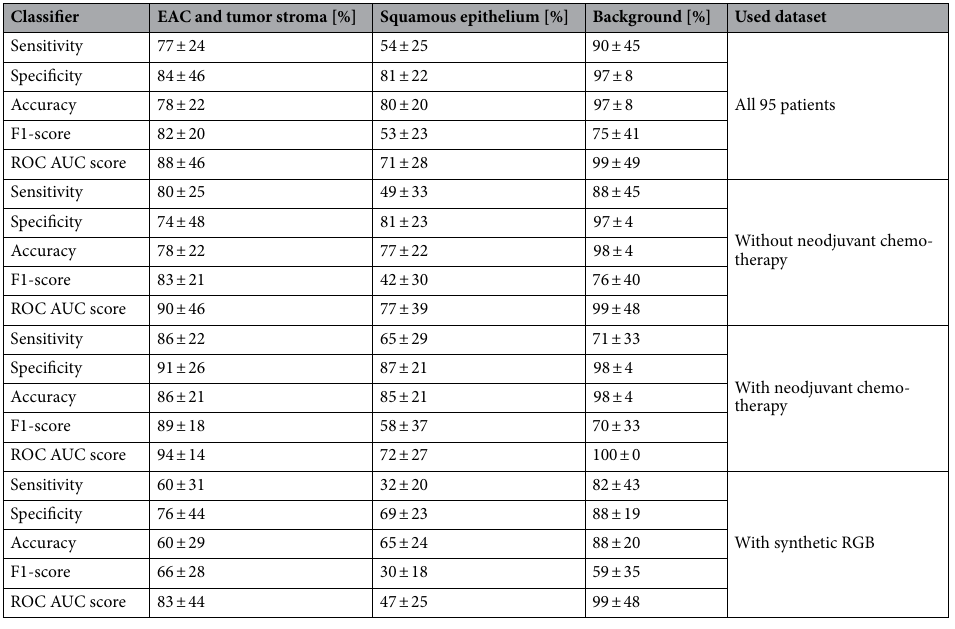
Table 1. Classification results of the multi-layer perceptron